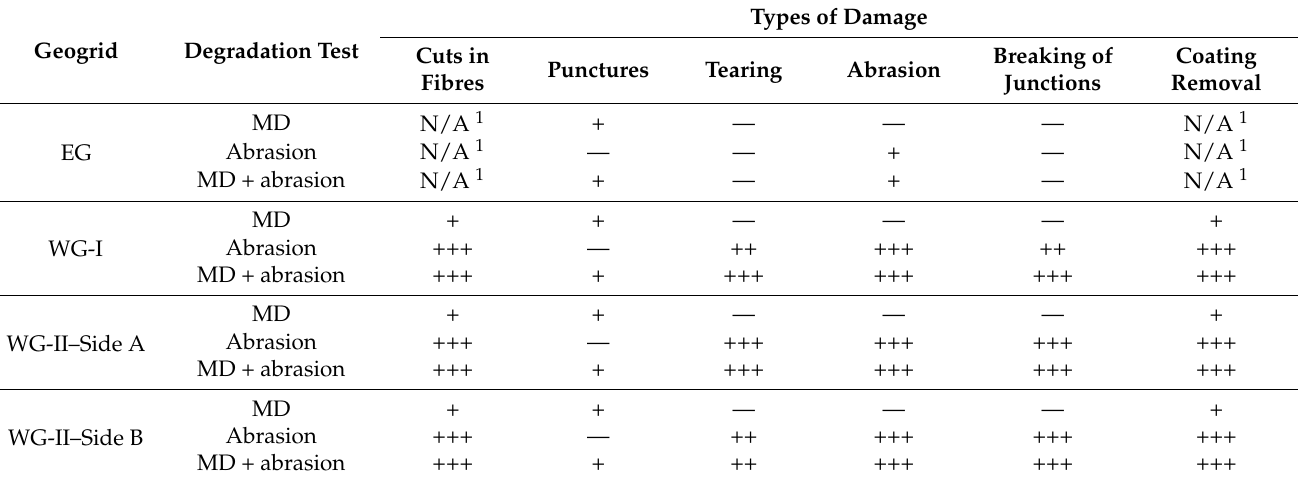
Table 2. Damage observed in the geogrids after the degradation tests. Geogrid Degradation Test